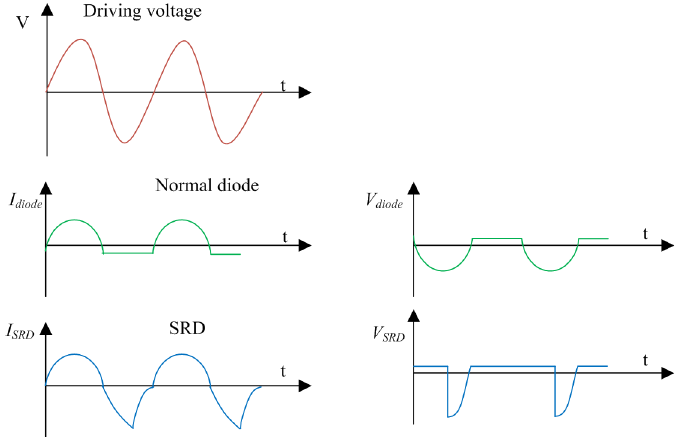
Fig 2. Voltage and current characteristics curves of common diode and SRD.